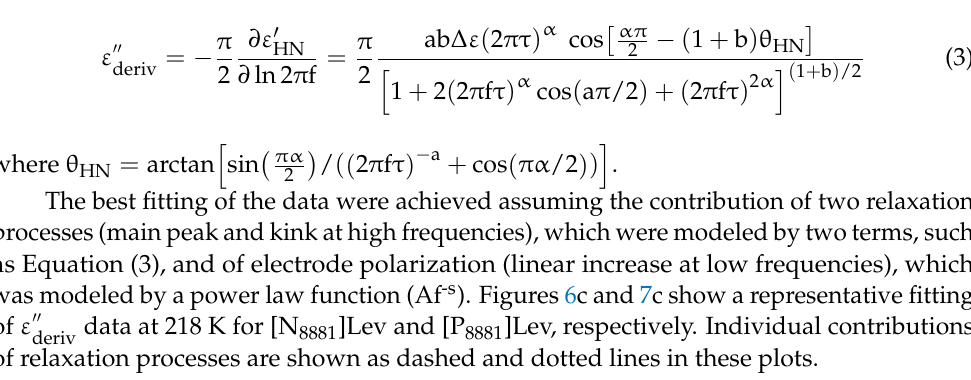
(f) in ( c ), and M”(f) in ( d ). deriv